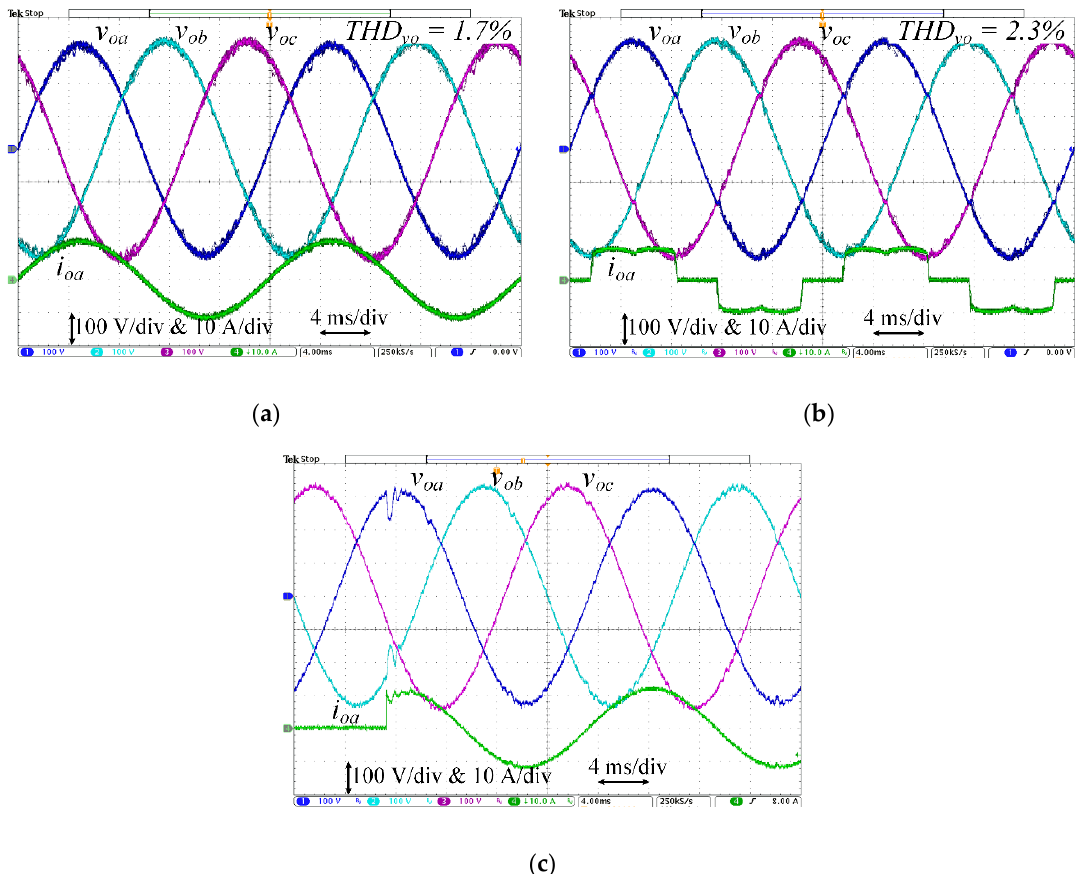
Figure 9. Experimental results showing performance of the proposed adaptive MPC under different conditions, ( a ) and ( b ) steady-state performance under linear and nonlinear loads, and ( c ) transient performance under step-change of the load from zero to 5 kW.